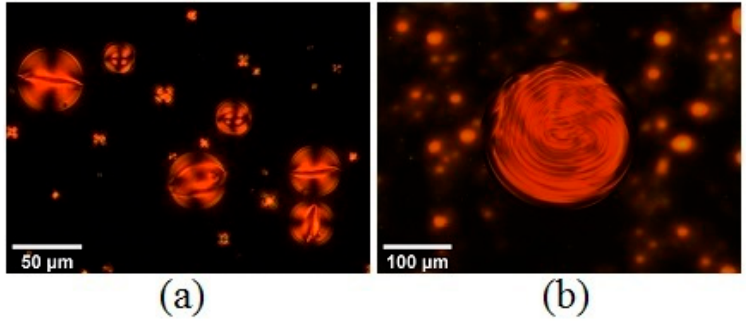
Figure 19. ( a ) POM images of the microspheres containing SSY doped with L-Lysine 10 wt% in PDMS, showing a toron-like texture and an intermediate layer-like structure and ( b ) SSY with trans-Hyp 26 wt%, showing a Frank–Pryce-like texture. ( a , b ) Reprinted with permission from ref. [50]. Copyright 2022, Elsevier.